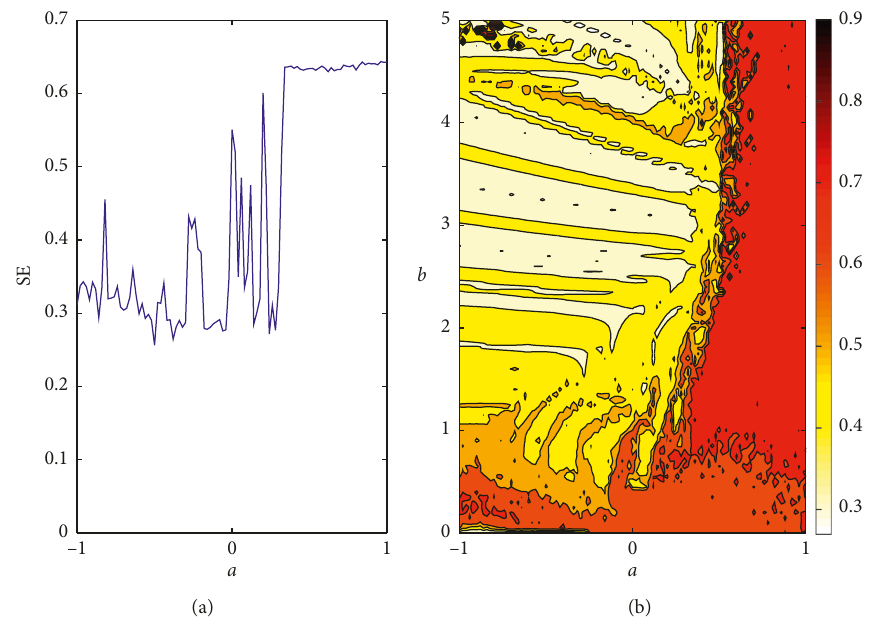
Figure 8: The complexity of SE of system (2): (a) SE versus a when b � 1 and (b) in the a − b plane.